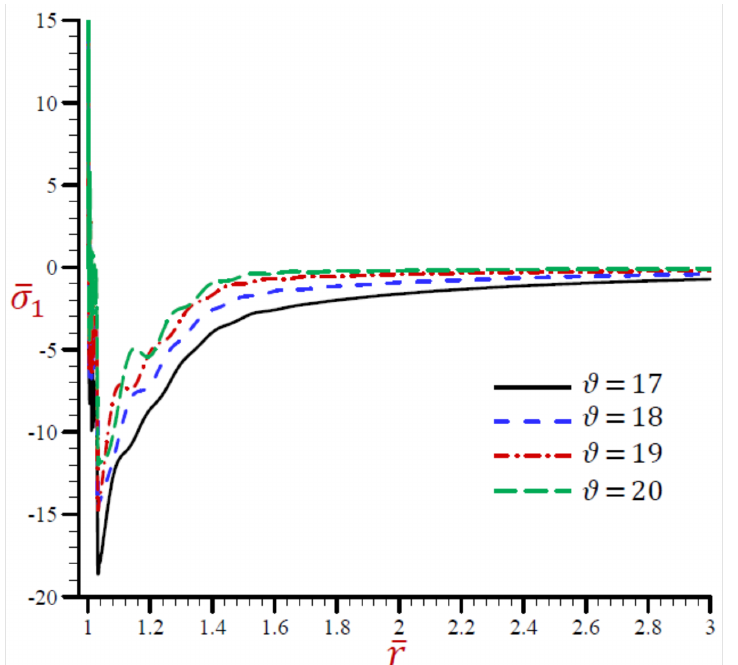
Figure 16. Effect of ϑ on radial stress σ 1 across the radial direction of the cylindrical cavity utilizing the RDPL model.